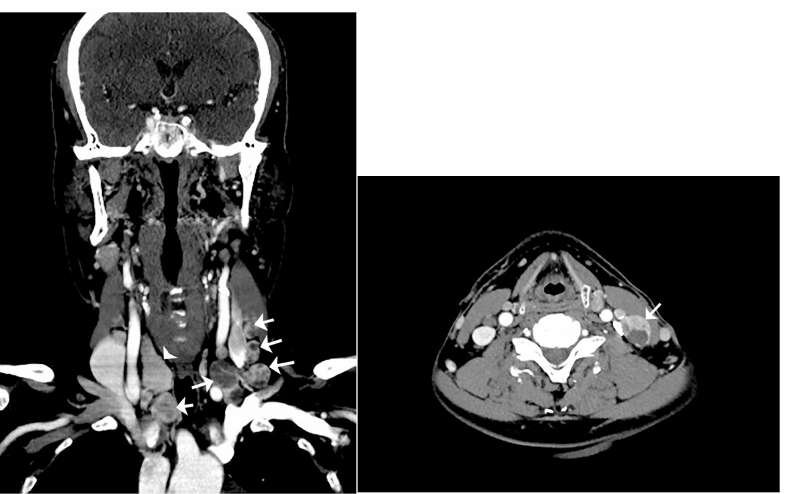
Figure 2. Computerized tomography (CT) scan of the neck. Left: coronal CT scan of the neck reveals multiple enlarged lymph nodes with internal variable cystic change involving bilateral neck of right level III and left levels II, III, and IV, and right lower cervical chain (arrow: multiple enlarged lymph nodes with cystic change; arrowhead: right lobe of thyroid). Right: axial CT scan of the neck reveals an enlarged lymph node with internal cystic change at left level III (arrow: the most enlarged lymph node with cystic change). Therefore, total thyroidectomy and cervical lymph node dissection were performed to distin-guish lymph node metastasis of occult thyroid cancer from seeding of thyroid tissue due to pre-vious thyroid surgery. Resected bilateral cervical lymph nodes were enlarged to the maximum dimensions of 3.5 × 1.7 × 1.0 cm. The cut surface of the lymph node and thyroid gland showed multiple variable-sized pale tan to brown solid nodules with cystic changes (Figure